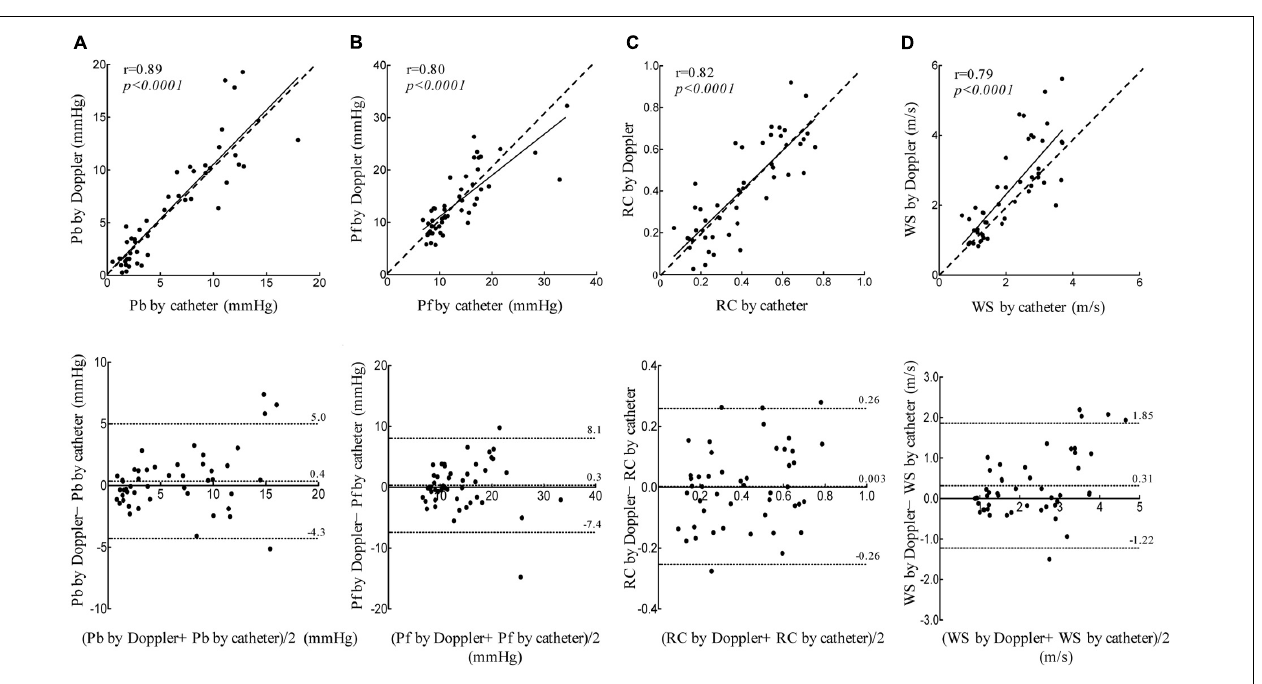
FIGURE 3 | Linear regression and Bland-Altman analyses. Linear regression (top figure, dashed line represents identical line.) and Bland-Altman (bottom figure, middle dashed line represents mean difference; dashed line of upper and lower represents the limits of agreement.) plots comparing catheter derived and echo-Doppler derived Pb (A) , Pf (B) , RC (C) , and WS (D) . The limits of agreement are defined as the mean difference ± 1.96 SD of